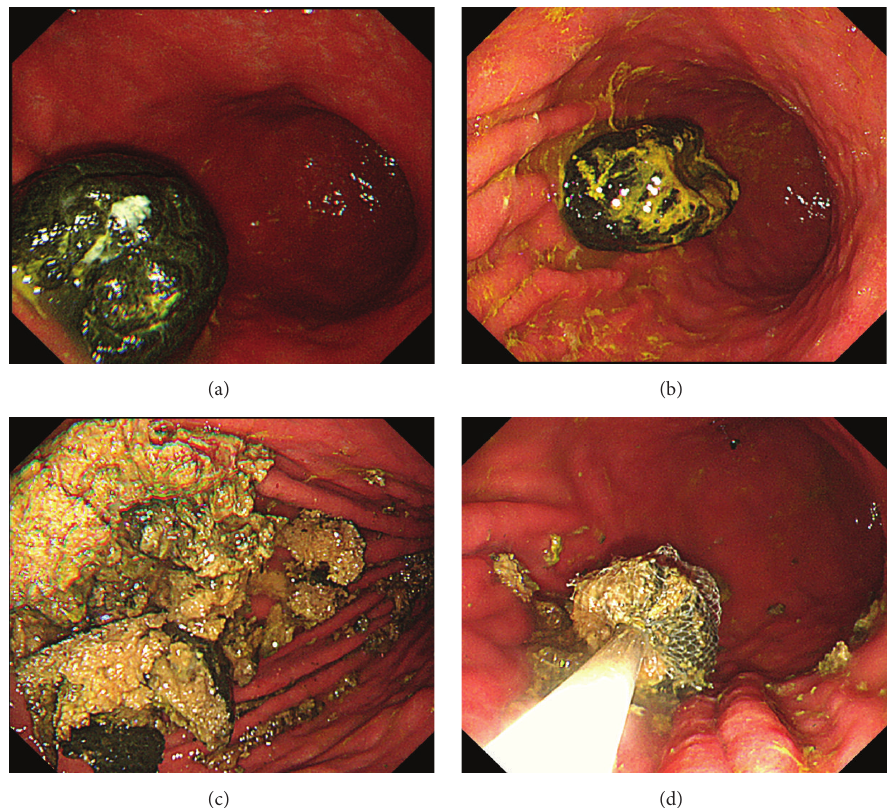
Figure 1: (a) Approximately 5 cm of the bezoar in the stomach before the dissolution therapy. (b) The bezoar showed depression on its surface after the dissolution. (c, d) The bezoar became softer after the dissolution made the endoscopic procedure